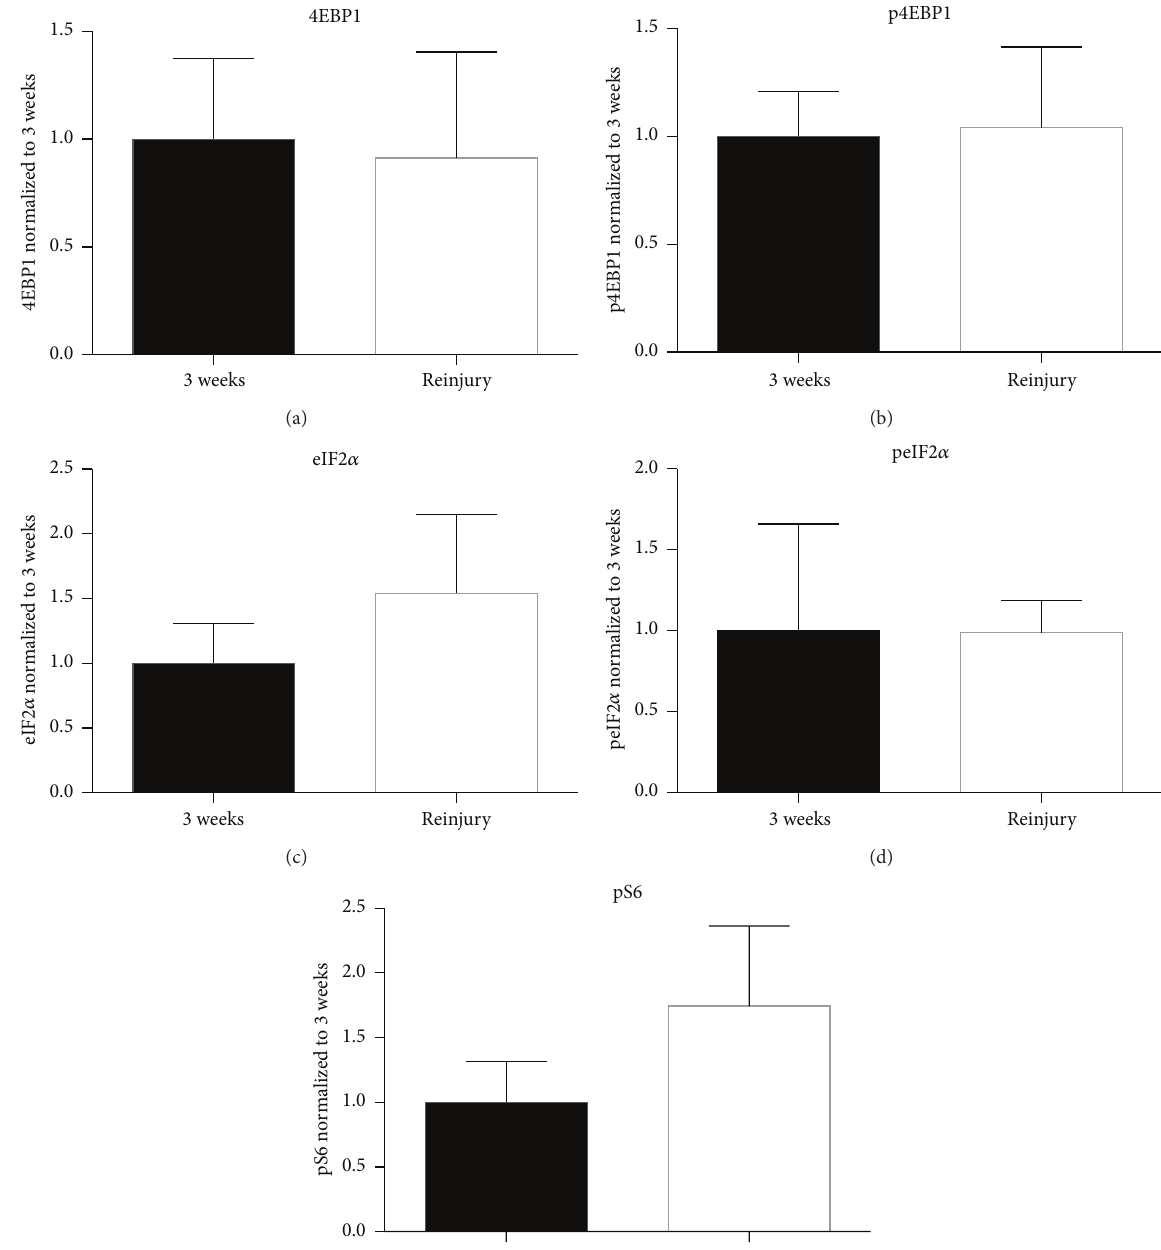
Figure 4: Translational machinery in reinjured and actively growing axons is comparable. Graphs (a)–(e) show quantification of relative immunolabeling intensity for the subtracted axon-only signals for 4EBP1, p4EBP1, eIF2 𝛼 , peIF2 𝛼 , and pS6, respectively. Data are expressed as fold change in signal intensity after reinjury at 7-week compared with 3-week PNGs ± SD, using Holm-ˇS´ıd´ak post hoc test. No significant differences were seen between the two groups; however the levels of pS6 between the two groups trended towards significance ( 𝑝 = 0.07